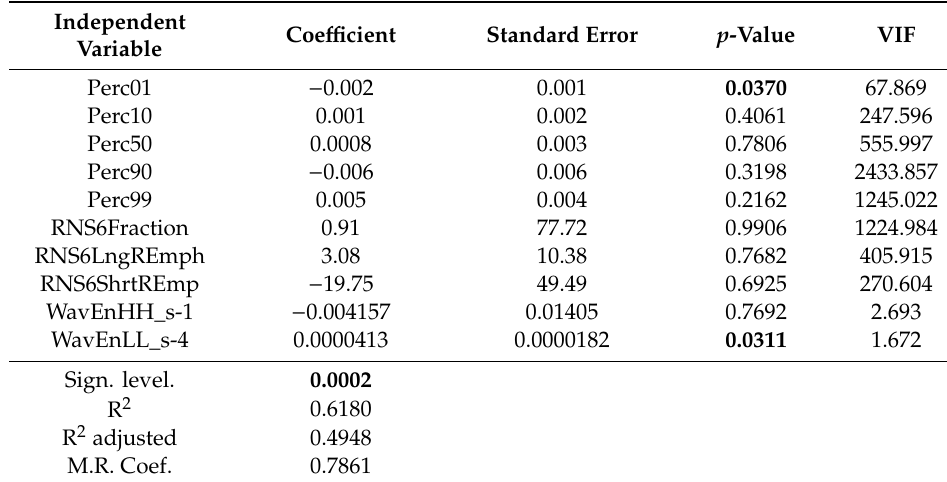
Table 5. Multivariate analysis of factors independently associated with the presence of high-grade gliomas. Bold values are statistically